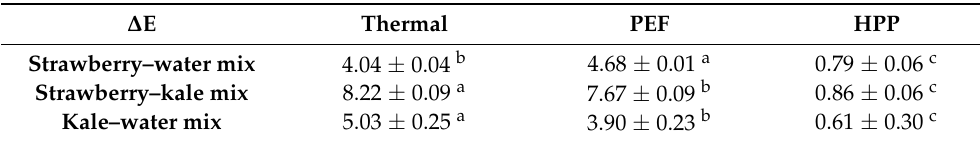
Table 3. Color differences ( ∆ E ) compared to the respective untreated systems directly after processing. Different letters indicate significant differences for each compound ( p < 0.05) (n =